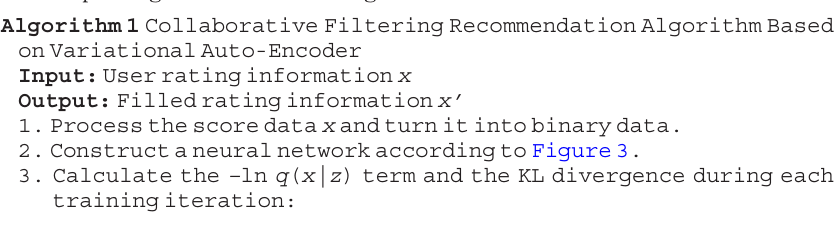
Algorithm 1 Collaborative Filtering Recommendation Algorithm Based